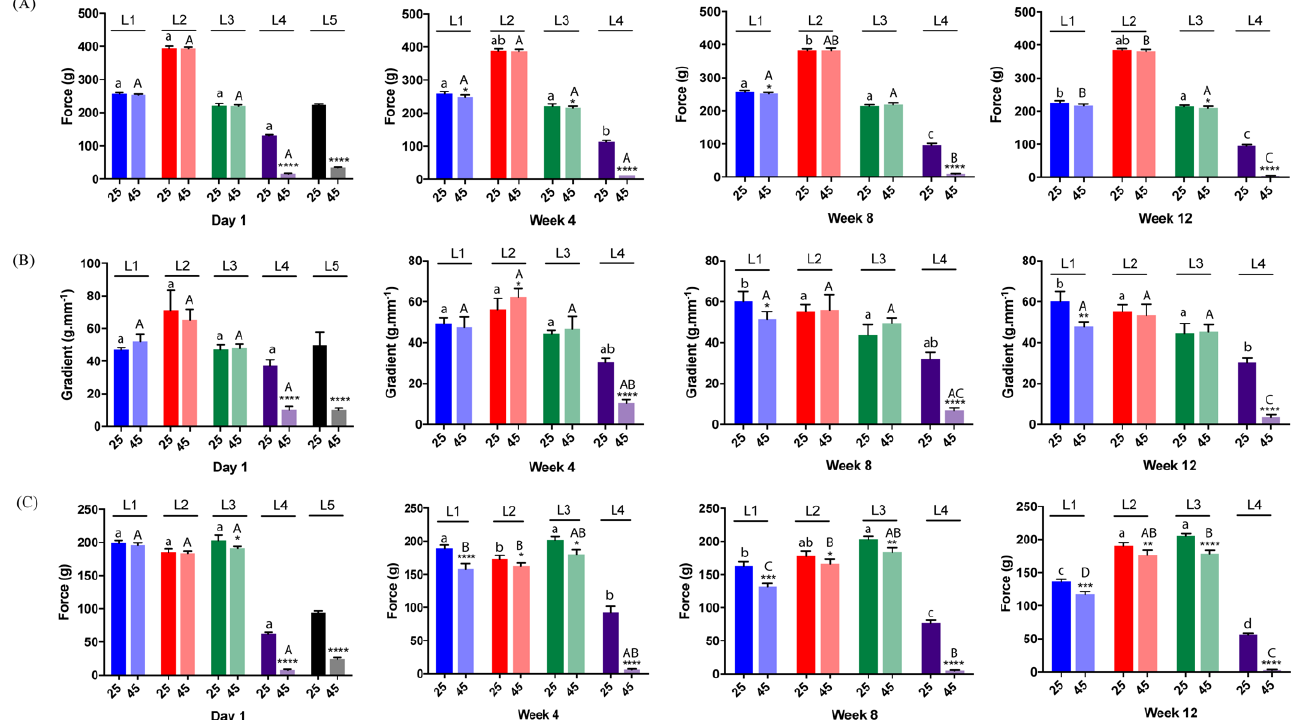
Figure 2. Mechanical profiles of lipsticks. Hardness ( A ), stiffness ( B ) and firmness ( C ) during stability studies carried out for 1, 28, 56, and 84 days, at 25 and 45 ◦ C. Force values are expressed as mean ± SD of n = 6 lipsticks per group. Different lower-case letters indicate a significant difference for hardness, firmness or stiffness between days of the same formulation at 25 ◦ C and different capital letters indicate a significant difference among different days of the same formulation at 45 ◦ C (one-way ANOVA, p < 0.05). Asterisk indicates a statistical difference between 25 and 45 ◦ C for the same formulation in the same day. *: p < 0.05, **: p < 0.01, ***: p < 0.001, ****: p < 0.0001, paired t -test.